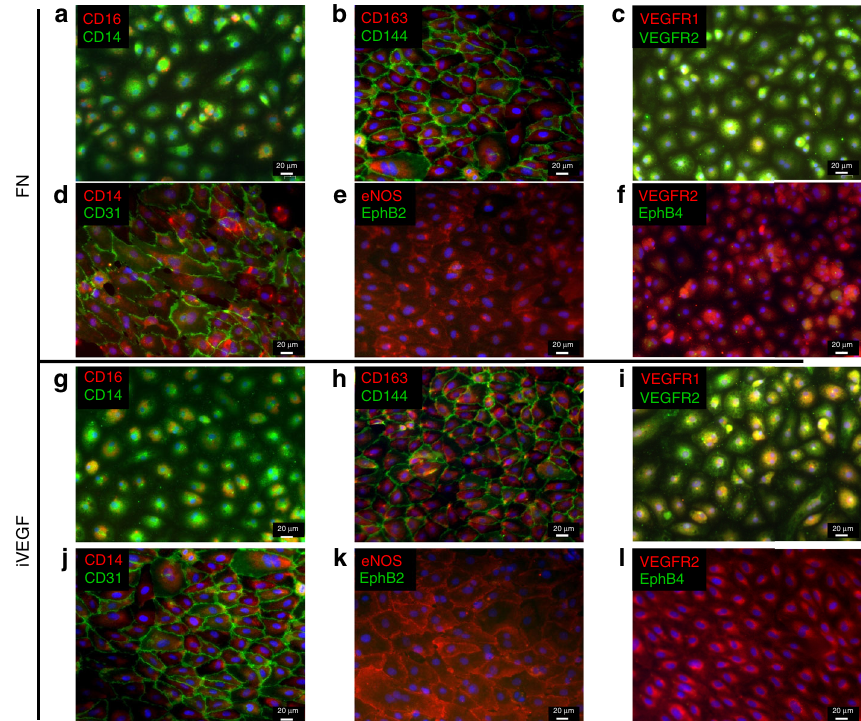
Fig. 6 Phenotypic changes during MC-derived EC. Immunostaining for MC and EC markers after 14 days of differentiation on FN ( a – f ) or iVEGF ( g – l ). a , g CD16 (red) and CD14 (green); b , h CD163 (red) and CD144 (green); c , i VEGFR1 (red) and VEGFR2 (green); d , j CD14 (red) and CD31 (green); e , k eNOS (red) and EphB2 (green); f , l VEGFR2 (red) and EphB4 (green). Scale bars: 20 μ m. Representative images from n = 10 independent biological